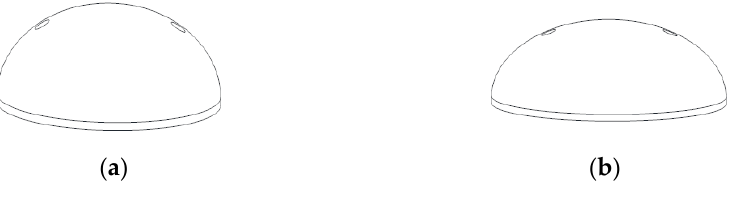
Figure 28. Improved recovery cover: ( a ) axis length 1.6 m; ( b ) axis length 2.0 m.